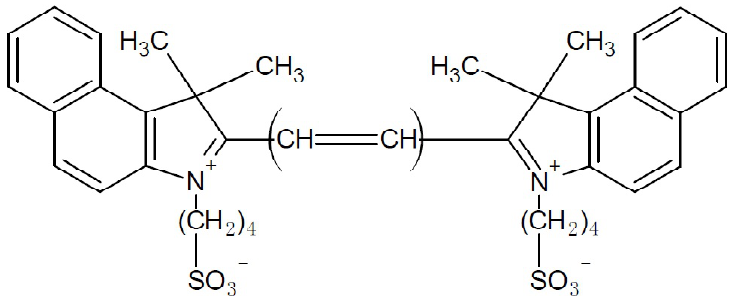
Scheme 5. Equation of indocyanine